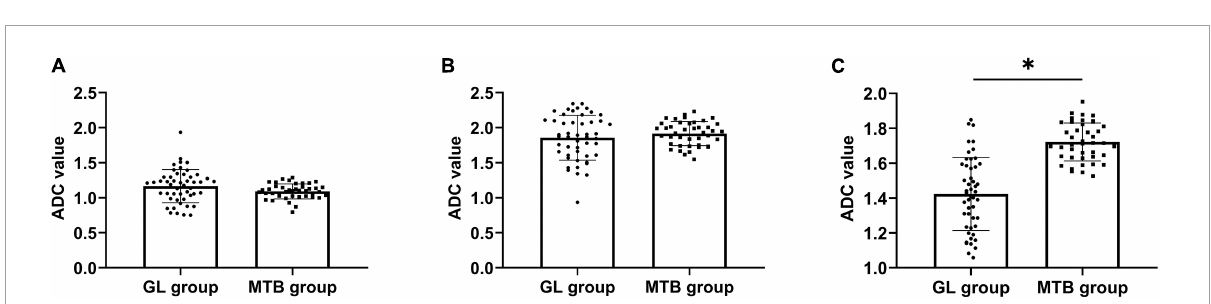
FIGURE4 Comparison of ADC values between patients with GL and MTB. (A) Comparison of ADC values of the tumor parenchyma area. (B) Comparison of ADC values of the tumor cystic area. (C) Comparison of ADC values of the peritumor edema area, * P <